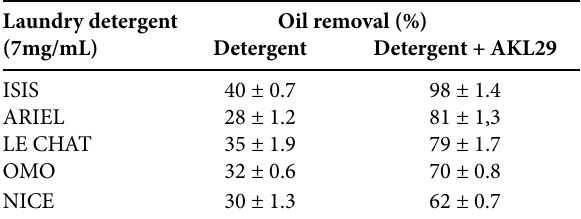
Table 7. Effect of partially purified AKL29 on removing sample stains from fat / fat (olive oil) sauce from cotton fabric with various commercial laundry detergents.